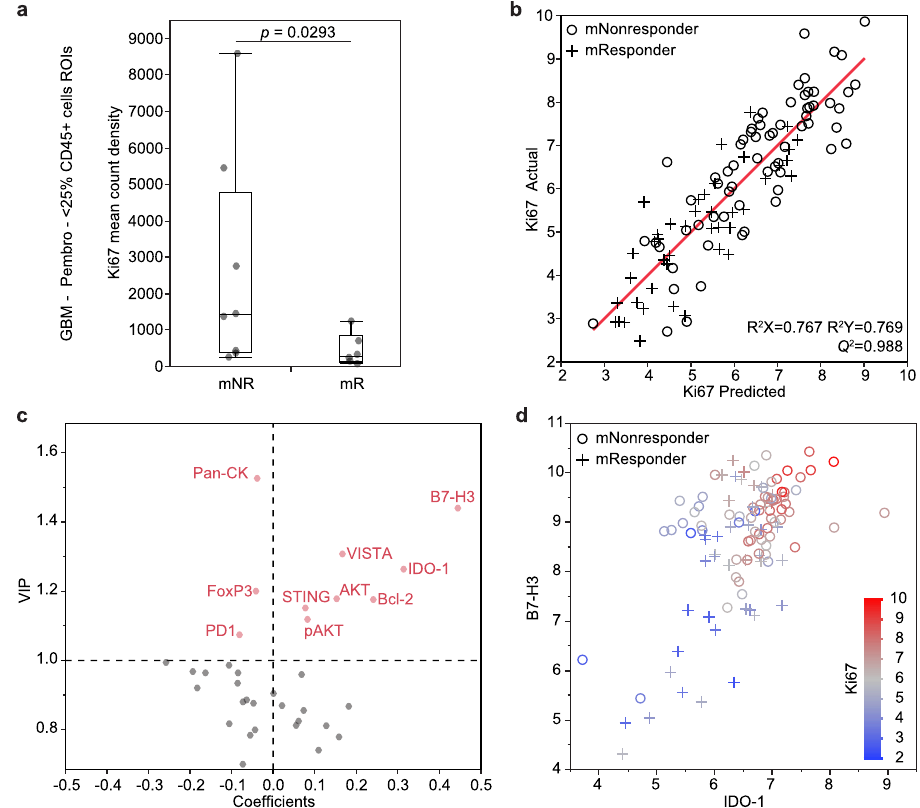
Fig. 4 Micro-tumor analysis reveals correlates of tumor proliferation. a Box plots of Ki67 expression in the immune-poor regions of interest in GBM samples treated with pembrolizumab (Pembro) ( n = 8 mNR and 6 mR). The horizontal line in each box represents the median sample value, the ends of the box represent the 25th and 75th percentiles, and the whiskers extend from the ends of the box to the outer most data points. The comparison was made using a two-sided Mann – Whitney U -test ( U = 7). b , c PLS regression analysis of immune-poor regions of interest with Ki67 as output in GBM samples treated with pembrolizumab. Plot of actual observations versus model predictions of Ki67 expression ( b ). Plot of variable importance in the projection (VIP) versus model coef fi cients ( c ). The dashed horizontal line represents the VIP > 1.0 cutoff and the dashed vertical line is where the model coef fi cient is 0. d Plot of B7-H3 versus IDO-1, color-coded with Ki67 level (red: high, blue: low). mNR molecular nonresponder, mR molecular